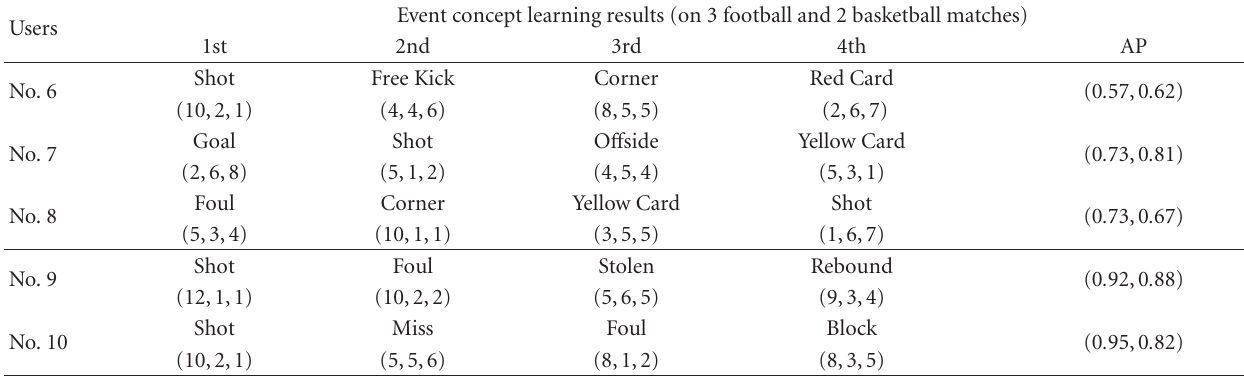
Table 8: Learned user preference on event